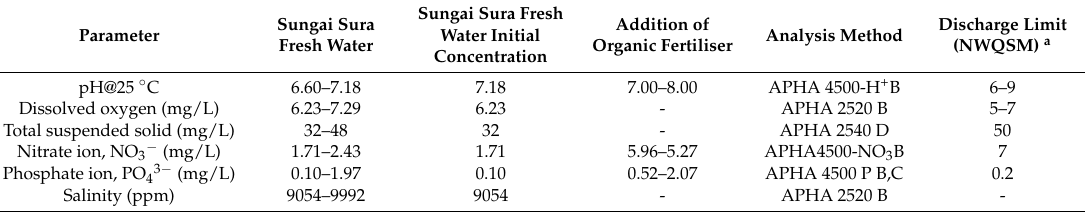
Table 1. The characteristics of raw water from Sungai Sura nearby UiTM Dungun.